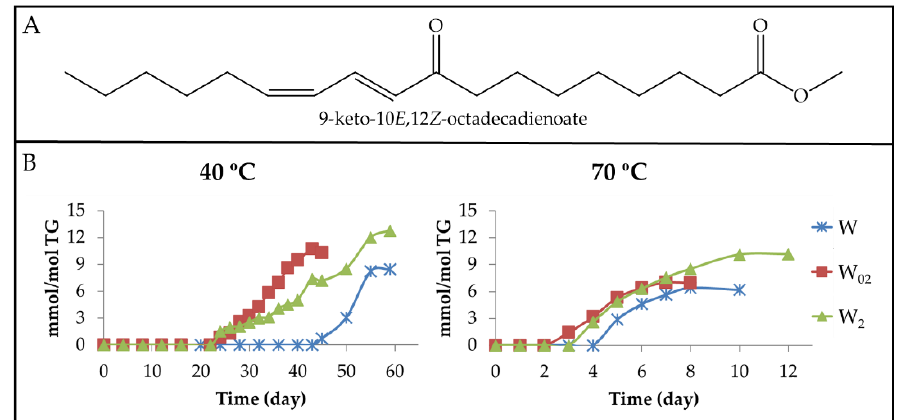
Figure 10. ( A ) Structure of 9-keto-10 E ,12 Z -octadecadienoate as an example of mKO-c( Z , E )-dE. ( B ) Evolution of the concentration expressed as mmol/mol TG, of mKO-c( Z , E )-dEs in walnut oil, with different enrichment levels of αT (W, W 02 and W 2 ), submitted to either 40 °C or 70 °C, up to advanced stages of the oxidation process.